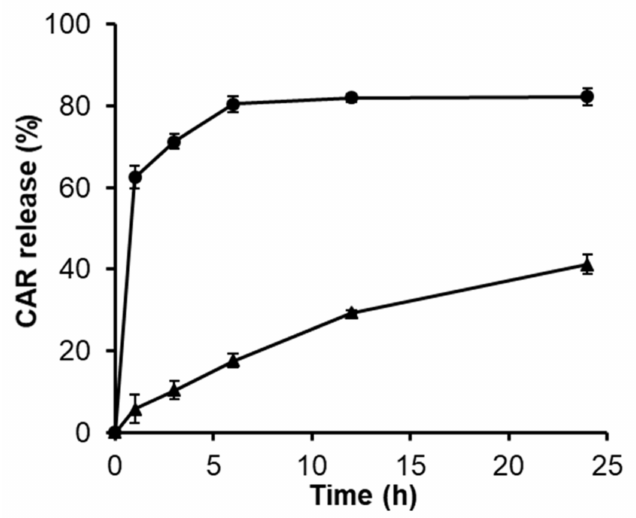
Figure 7. Release profiles of CAR from PAMAM G3.0@mPEG (triangle). The release of free CAR with equal amount to that loaded in PAMAM G3.0@mPEG was carried out as a control